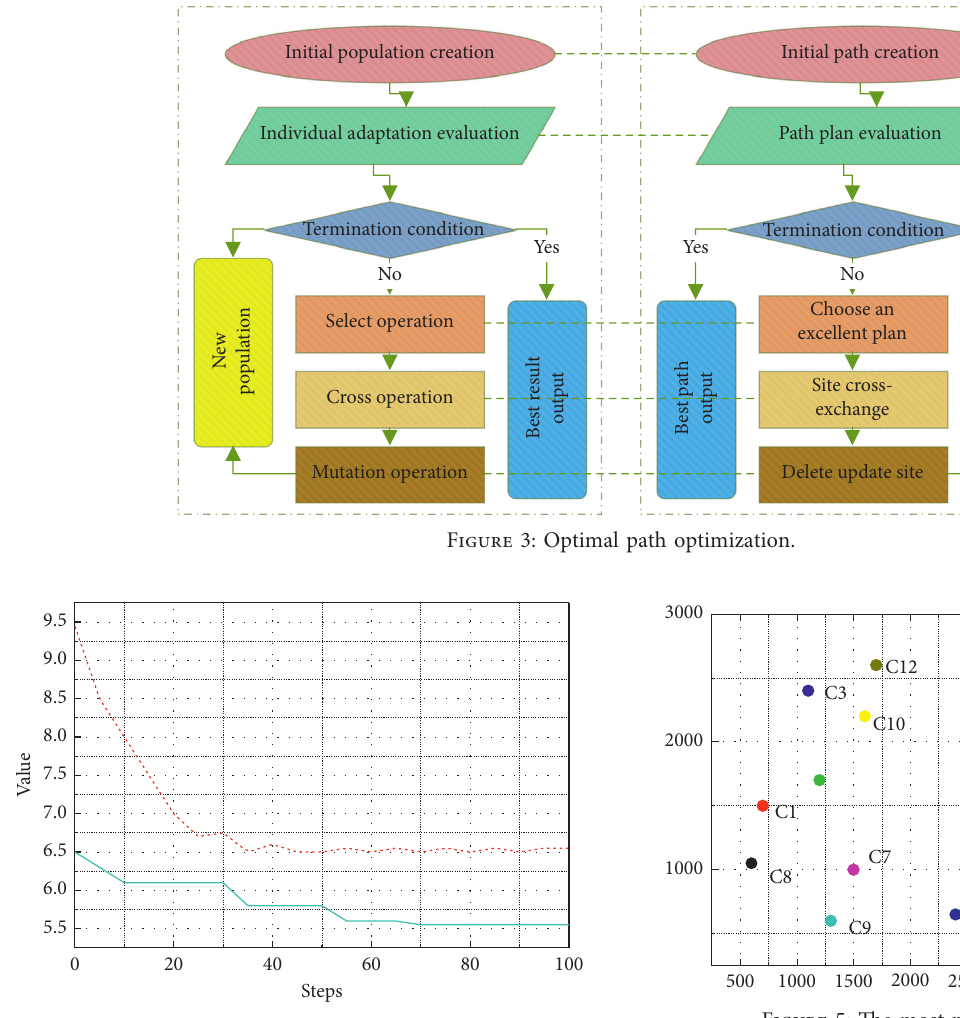
Figure 5: The most preferred site